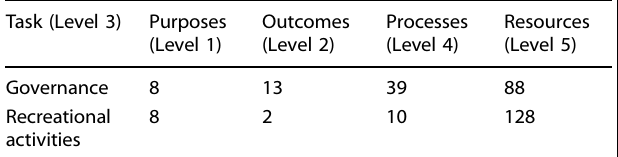
Table 6. Number of nodes that the Task Governance is connected to across each level of the USAH in comparison to the Task Recreational activities